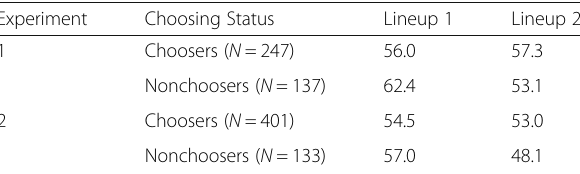
Table 2 Experiments 1 and 2: The Average Confidence Ratings for Consistent Choosers and Nonchoosers